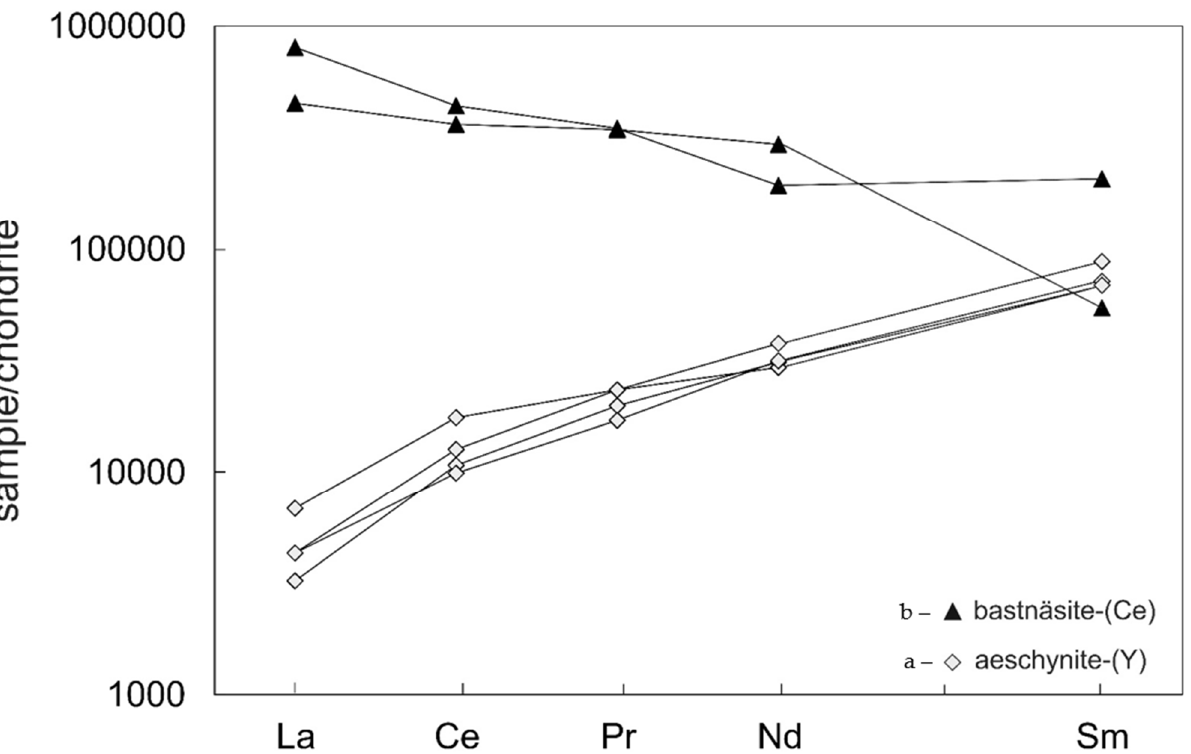
Figure 7. Chondrite ‐ normalized REE plots for ( a ) aeschynite ‐ (Y) and ( b ) bastnäsite ‐ (Ce). Normali ‐ zation factors from Sun and McDonough [8]. tion factors from Sun and McDonough